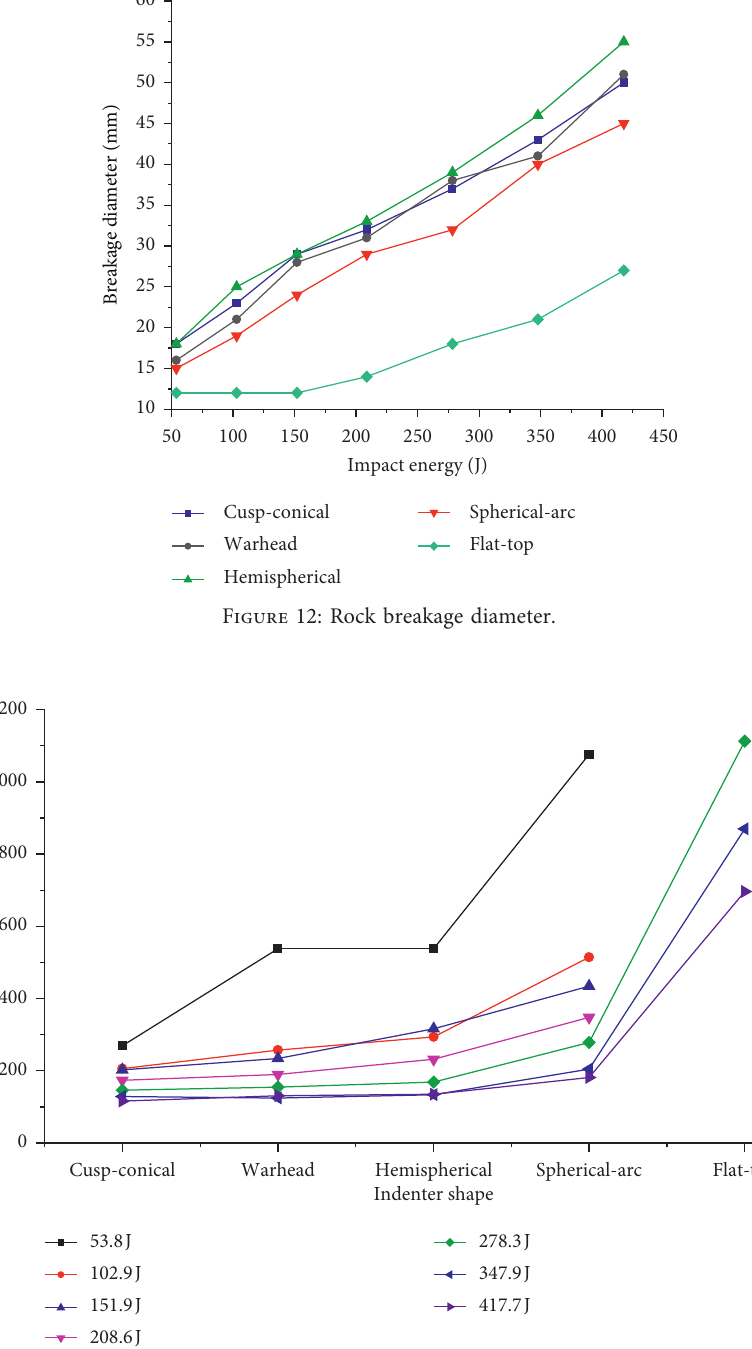
Figure 13: Specific energy